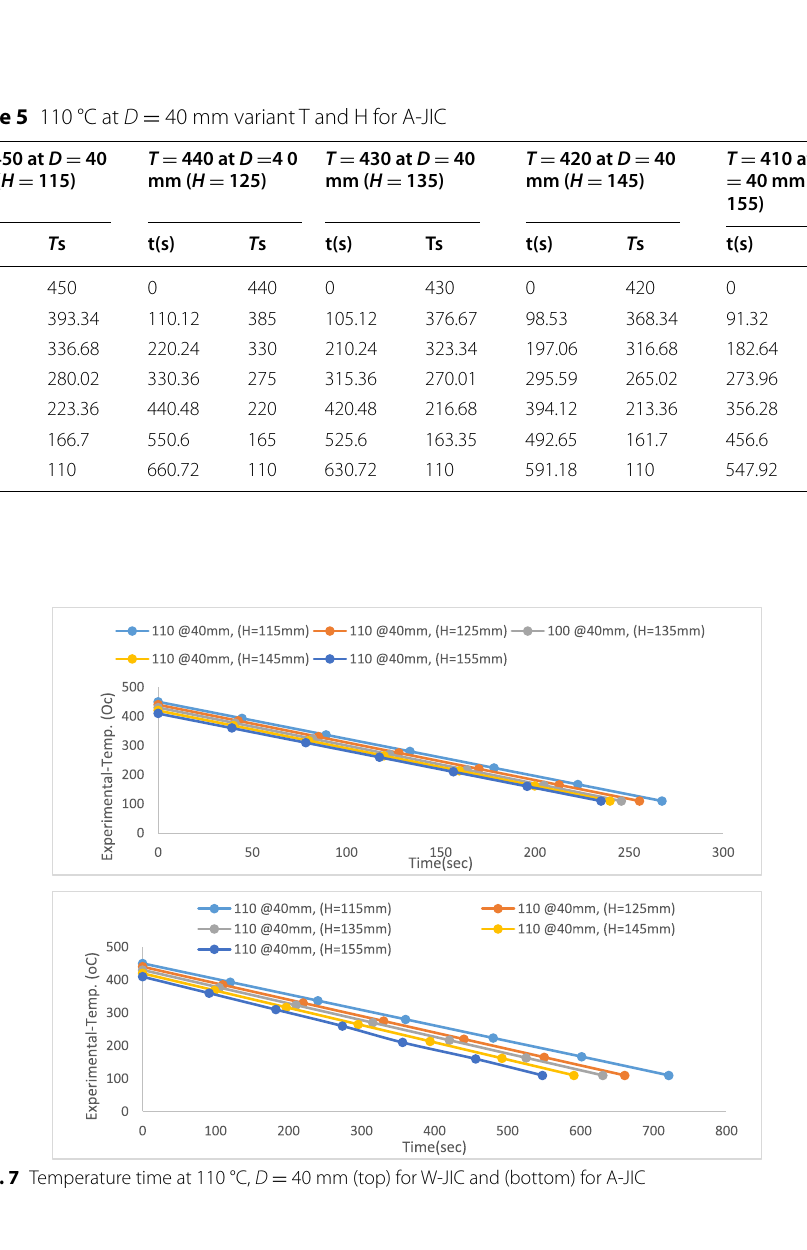
40 mm (top) for W-JIC and (bottom) for =